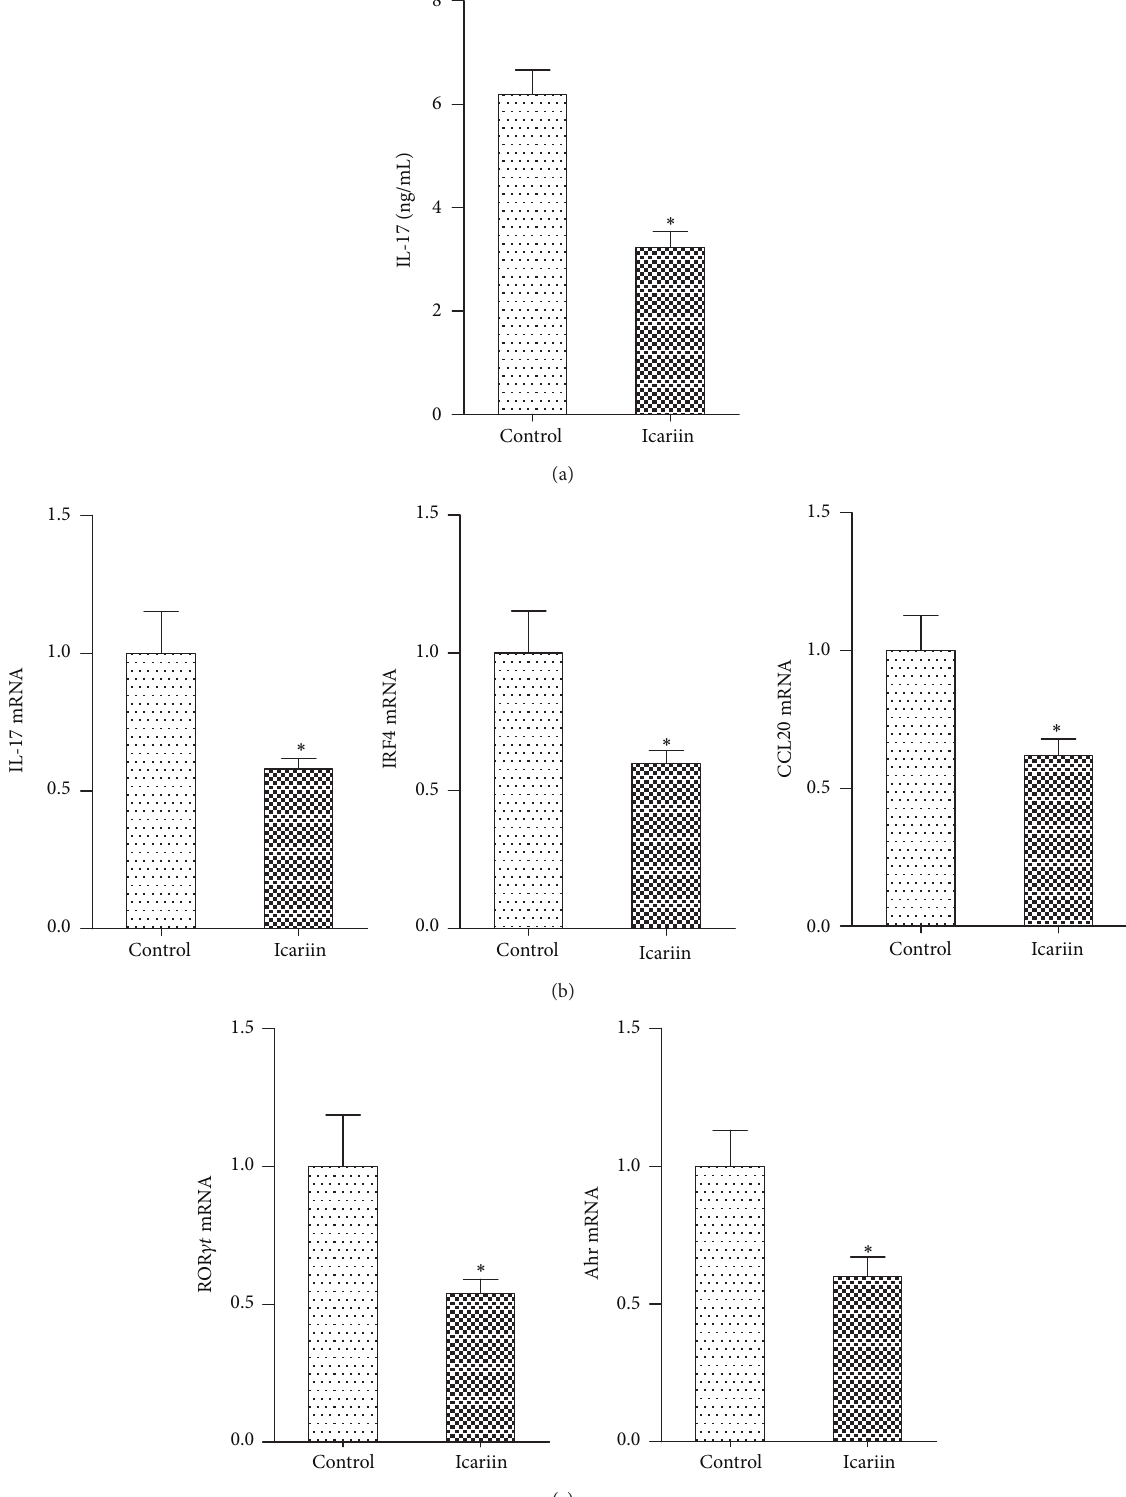
Figure 3: Icariin decreases Th17 cells and represses IL-17 production in vitro . CD4 + T cells from the spleens of mice were cultured under Th17 cell-inducing conditions with or without icariin (10 𝜇 M/L). (a) After 72 hours of culture, expression of IL-17 mRNA in the cell was determined using PCR. (b) The concentration of IL-17 in culture supernatants of mouse serum was measured using ELISA. (c) The mRNA expression of molecules that are associated with Th17 cell differentiation, including retinoic acid receptor-related orphan nuclear receptor 𝛾 t (ROR 𝛾 t), aryl hydrocarbon receptor, interferon regulatory factor 4, and CCL20, was determined using real-time PCR. ∗ 𝑃 < 0.05 versus all other groups, 𝑛 = 6